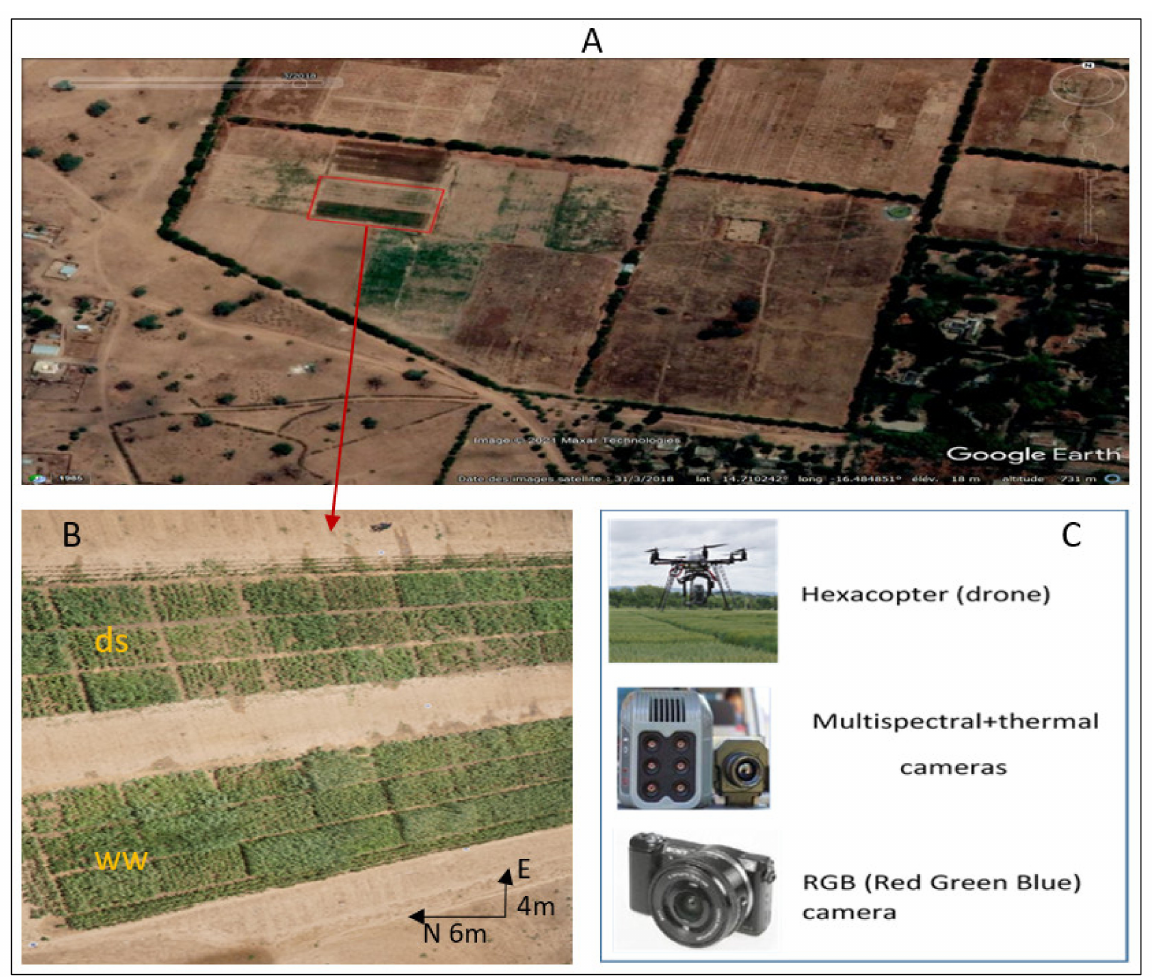
Figure 1. Field experiment and UVA with its accessories used in this study. ( A ) Google Earth map of experimental field location on 31 March 2018 (45th days after sowing), ( B ) picture depicting the overview of varieties under well-watered (ww) and drought stress (ds) conditions at the 76th days after sowing in 2018 field trial, ( C ) Drone and sensors. ww: well-watered; ds: drought